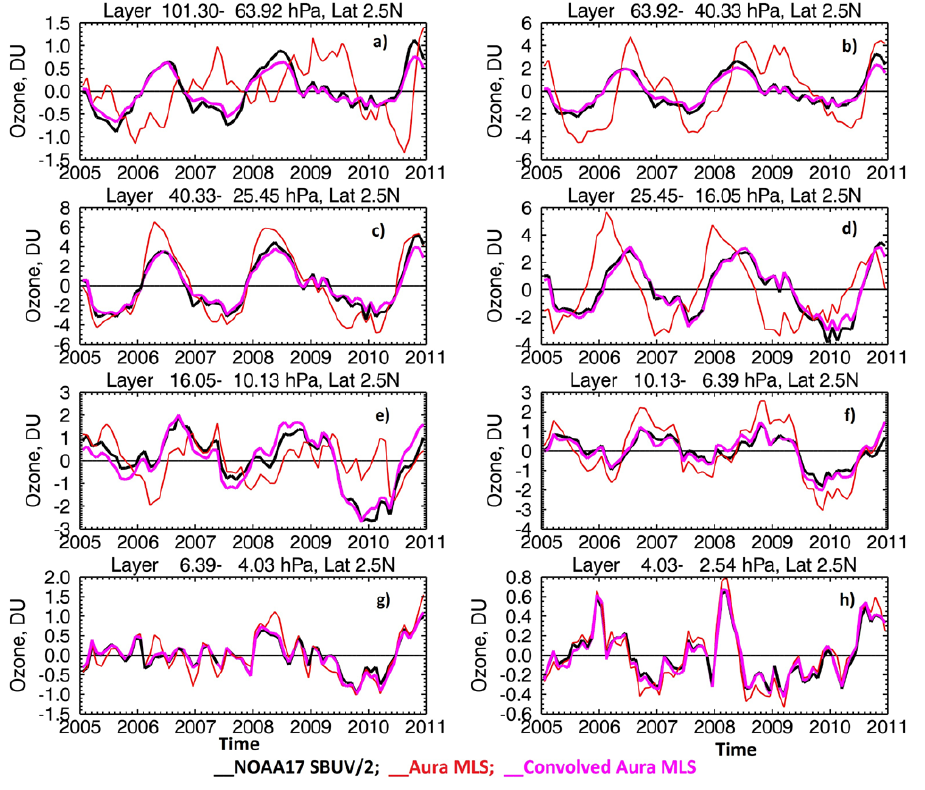
Fig. 1. Deseasonalized time series of the ozone mzm columns in the lower tropical stratosphere (0–5 ◦ N). Black lines correspond to SBUV anomalies, red lines show MLS anomalies and magenta lines indicate convolved MLS anomalies. The MLS mixing ratio profiles were converted first to the partial ozone columns at the SBUV